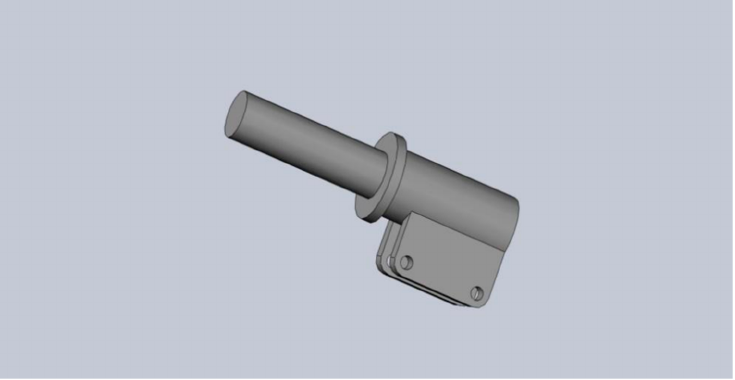
Figure 3. Leg joints model in Solidworks.